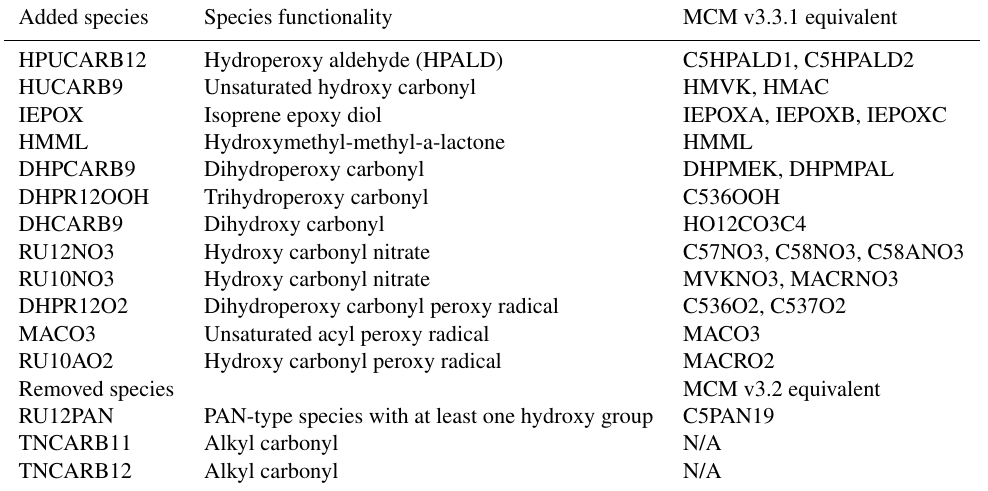
Table 2. Species added and removed from the CS mechanism in the development of the CRI-Strat 2